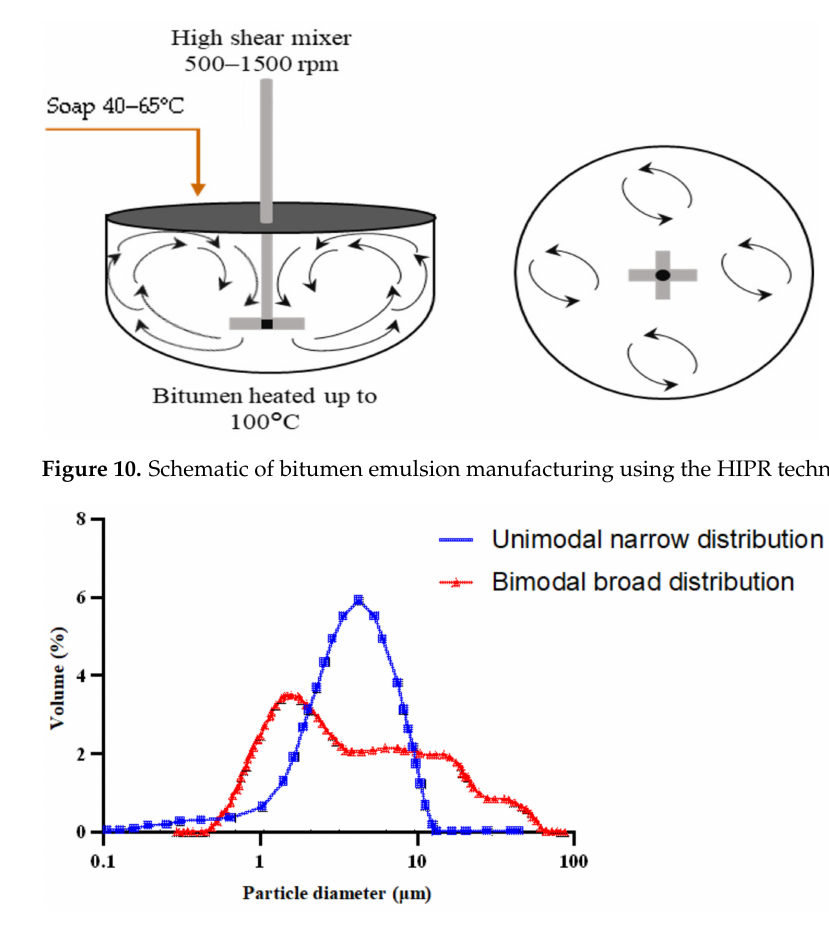
Figure 11. Unimodal and bimodal bitumen emulsion particle size distribution adapted from